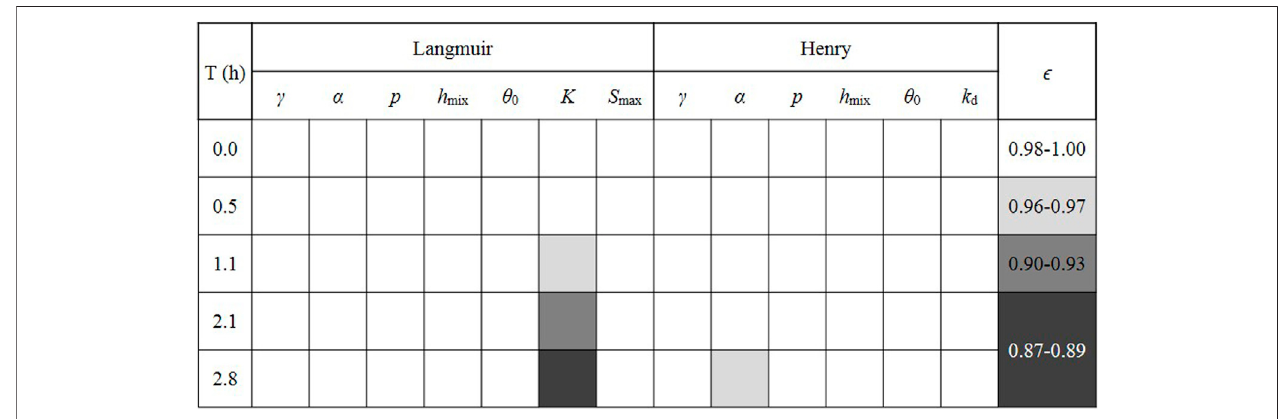
FIGURE 8 | The ϵ values of each parameter in the simulation during the rainfall